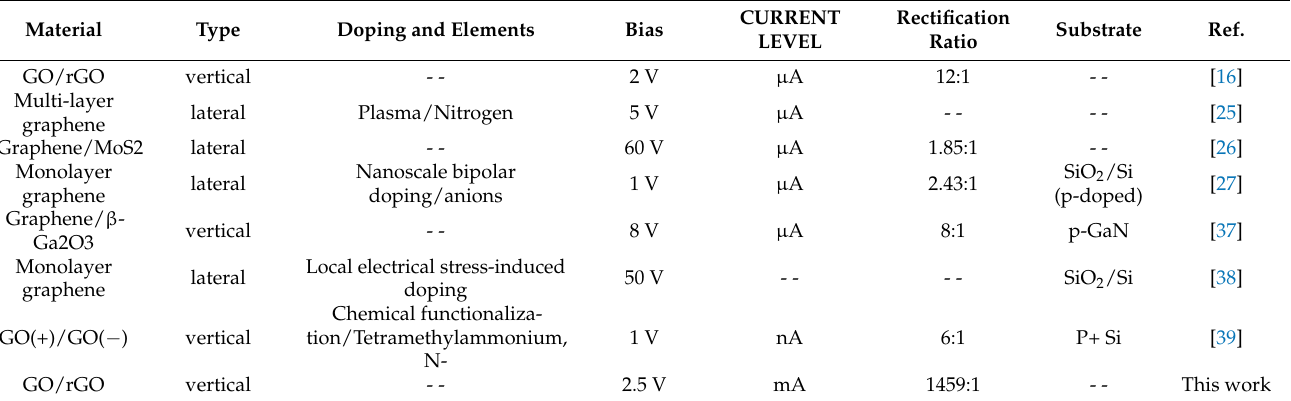
Table 1. Comparison of figures in graphene p-n junctions.